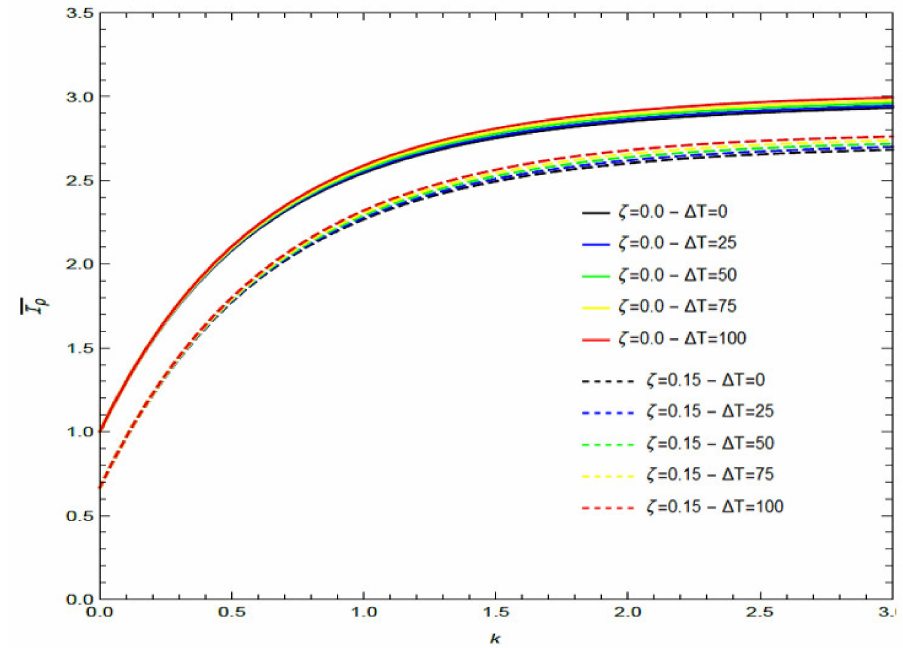
Figure 3. Combined effects of the gradient index ( k ) and the porosity volume fraction ( ζ ) on the dimensionless rotary inertia I ρ under uniform temperature rises ( ∆ T = 0, 25, 50, 75, 100